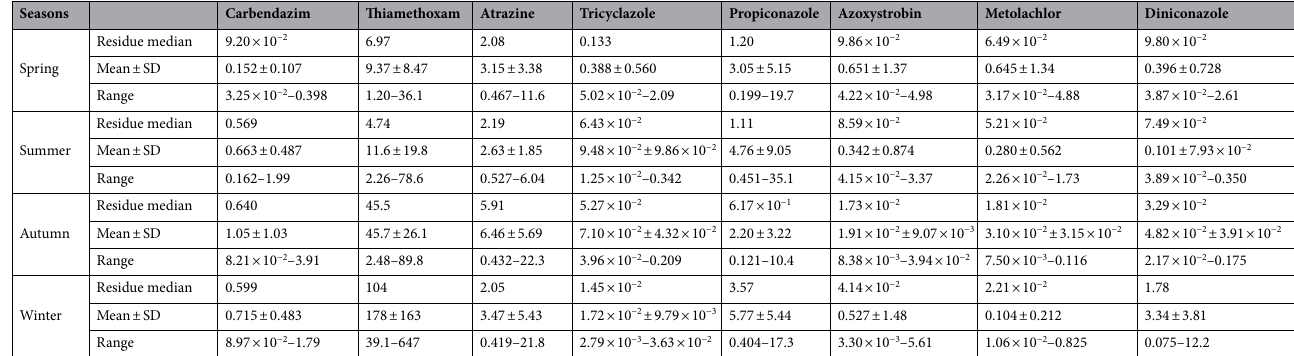
Table 2. The average residue level of thiamethoxam in soils. They were in the range of 1.20–36.1 μg/kg dw in spring and 39.1–647 μg/kg dw in winter, whilst other seven pesticides almost no significant fluctuation with the mean residue of below 6.46 μg/kg